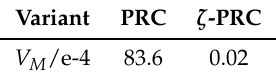
Table 13. Example 6. Comparing the following variants, ζ -PRC + Algorithm 1 with MP parameter and MTDE settings ¯ c = δ = 2.7 and ζ = 0.74, and the PRC + Algorithm 1 with MP parameter setting ¯ c = 2.5, using the main performance V M defined in Equation (42).